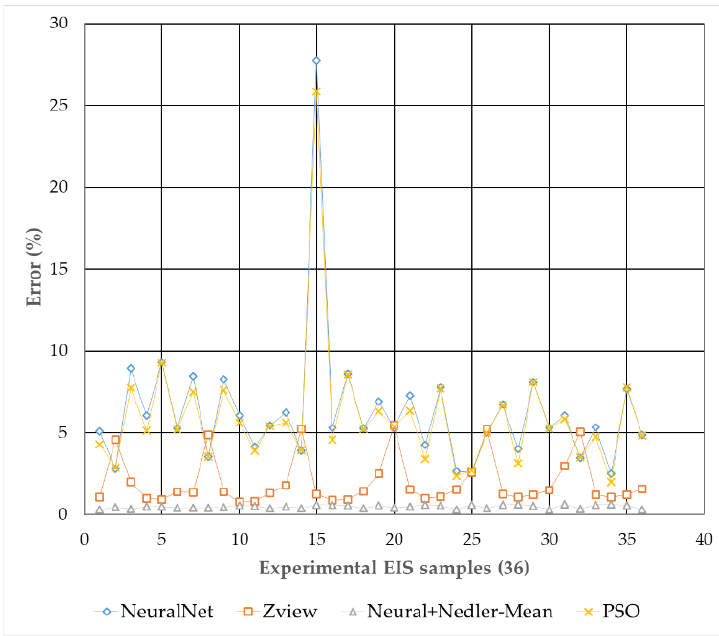
Figure 12. Final results and comparison with the experimental data. Average error corresponding to the estimation of the EEC parameters of the four benchmarked methods for the 36 EIS experimental dataset is compared in Table 3. Table 3. Average error of the four benchmarked methods for the 36 EIS experimental dataset. Benchmarked